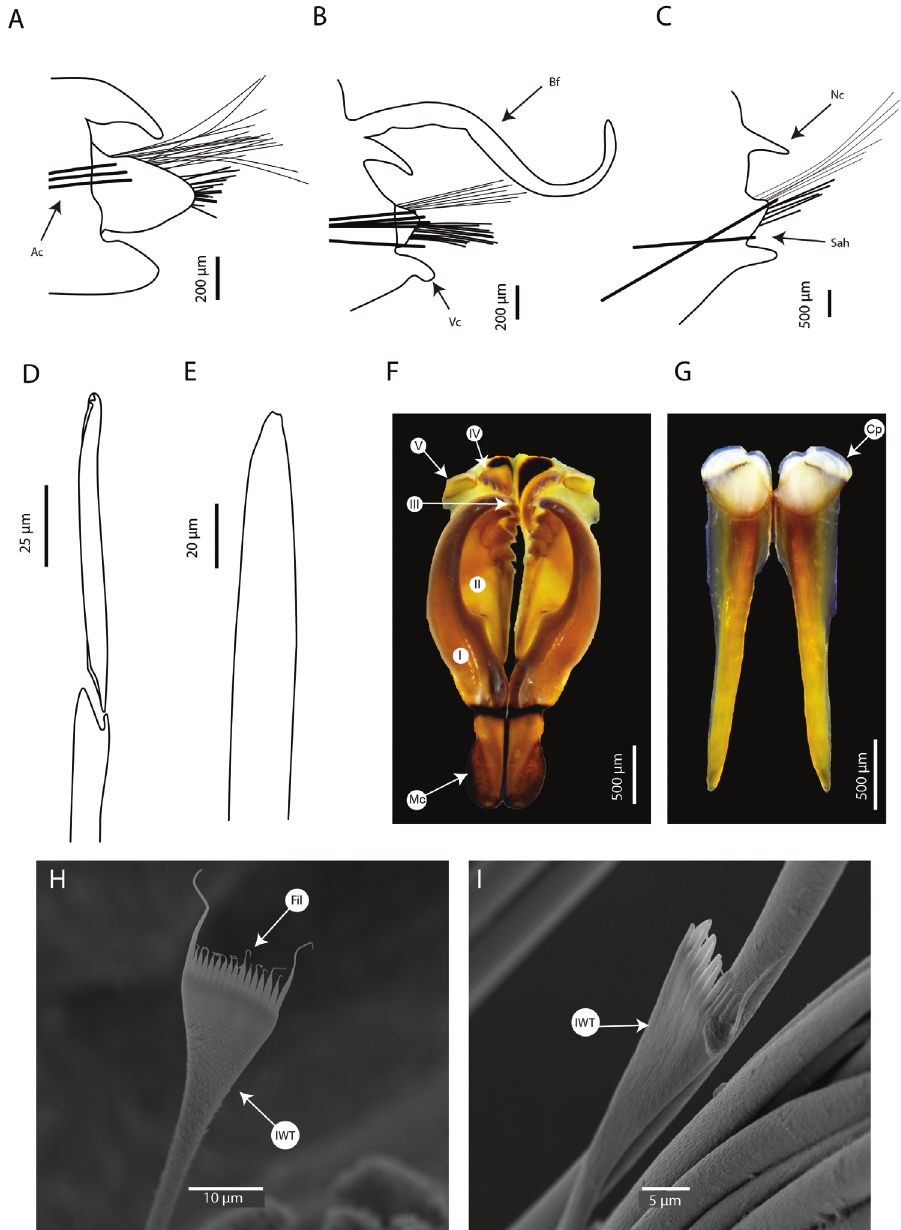
Figure 9. Marphysa zanolae sp. nov. holotype MNHN-IA-2015-1519 ( A–E ), paratype MNHN- IA-2015-1607 ( F, G ): A parapodia from anterior body (chaetiger 8) B parapodia from mid-body (chaetiger 31) C parapodia from posterior body D compound falcigers from anterior chaetiger (chaetiger 12) E subacicular hook from mid-body (chaetiger 43) F maxilla, dorsal view G mandibles, dorsal view H pectinate chaeta, chaeti- ger 48 I pectinate chaeta, chaetiger 33. Abbreviations: MI to MV, maxillae I to V; Ac, aciculae; Bf, branchial filament; Cp, cutting plate; Fil, filament; IWT, isodont-wide-thick; Mc, maxillary carrier; Nc, notopodial cirri; Sah, subacicular hook; Vc, ventral cirri. A–C Sah and Ac are illustrated schematically to indicate